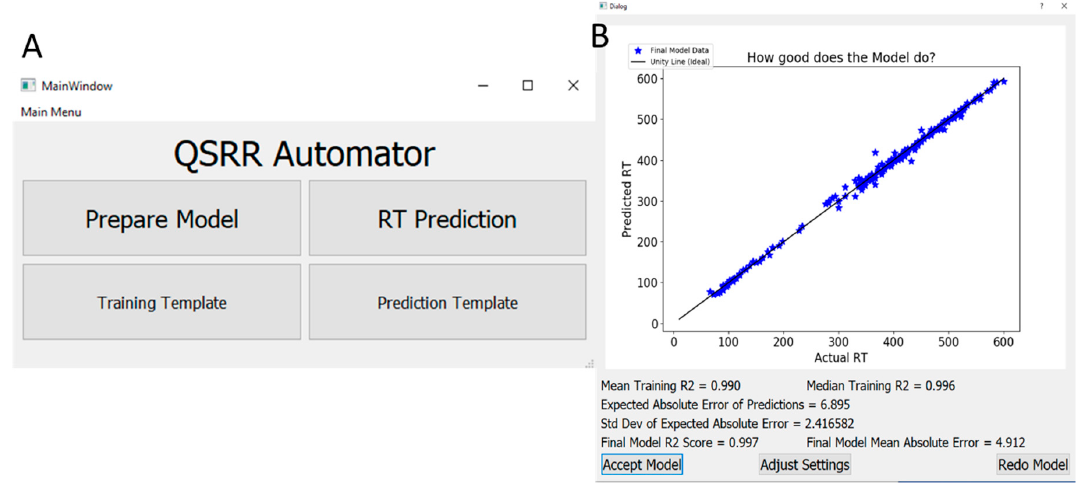
Figure 1. QSRR Automator ( A ). User interface for QSRR Automator. ( B ). Example model output of QSRR Automator using data from Aicheler et al. [1].